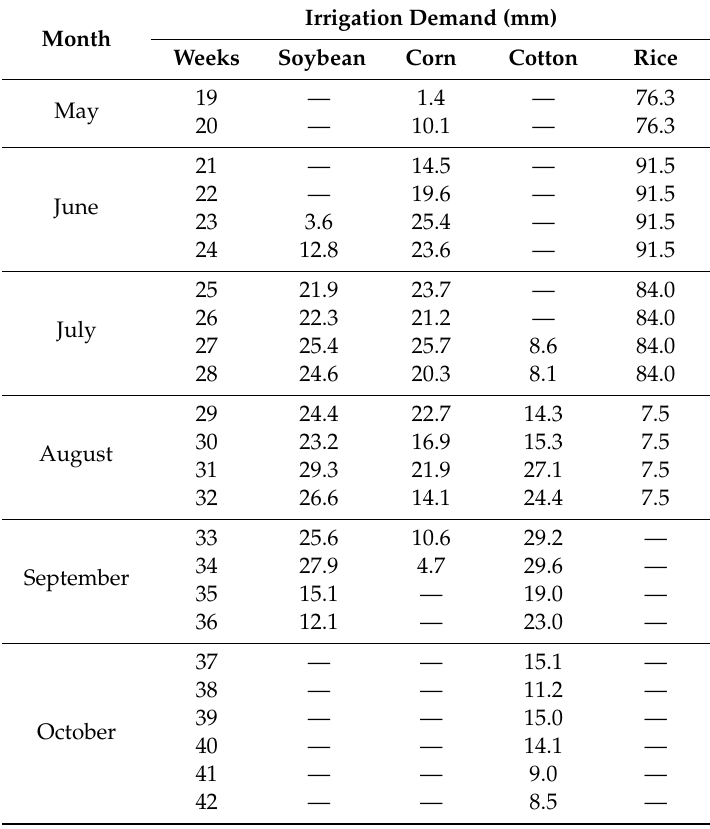
Table 2. Weekly irrigation demands for soybean, corn, cotton, and rice during growing season in Big Sunflower River